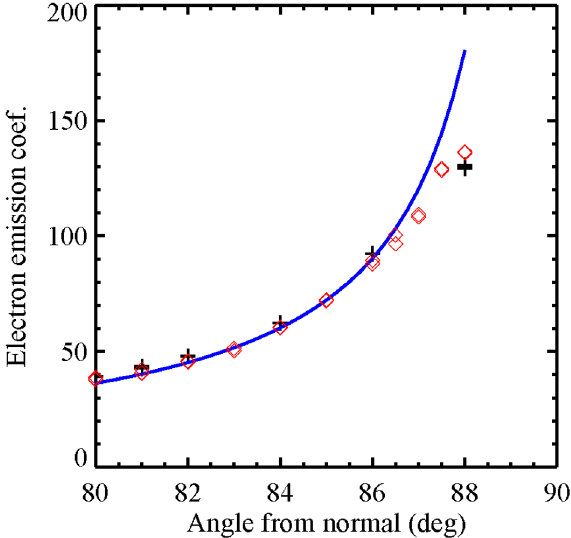
FIG. 10. (Color) Electron emission coefficient as a function of angle of incidence measured from normal, before (black +) and after baking at 220 (cid:1) C for 85 h (red diamonds). The blue line is given by 6 : 3 = cos (cid:2) (cid:4) (cid:3)